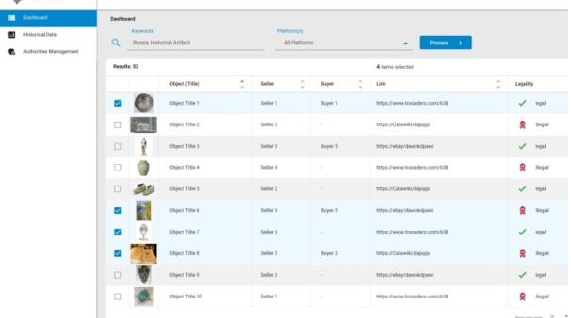
Figure 8. SIGNIFICANCE Platform: Dashboard